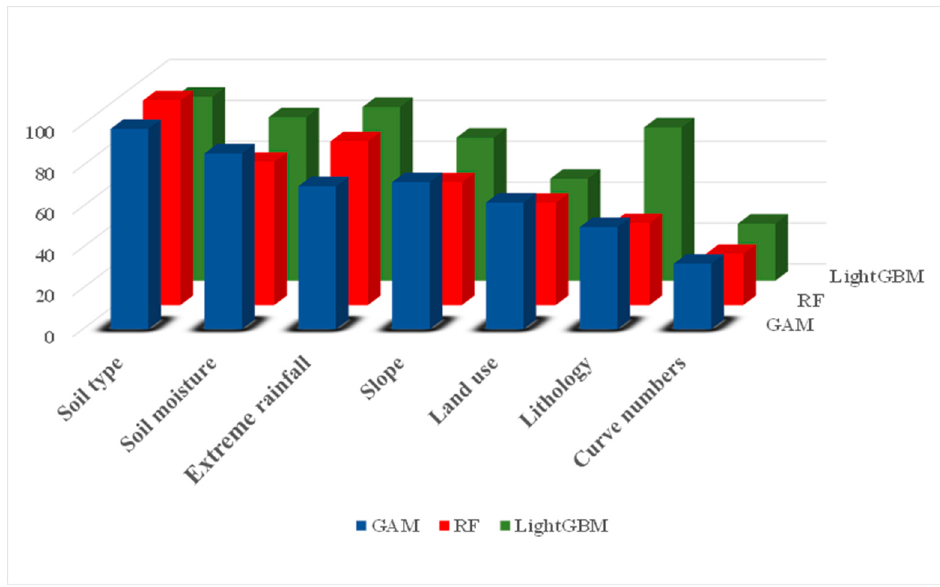
Figure 6. The relative importance of influencing factors by different models.